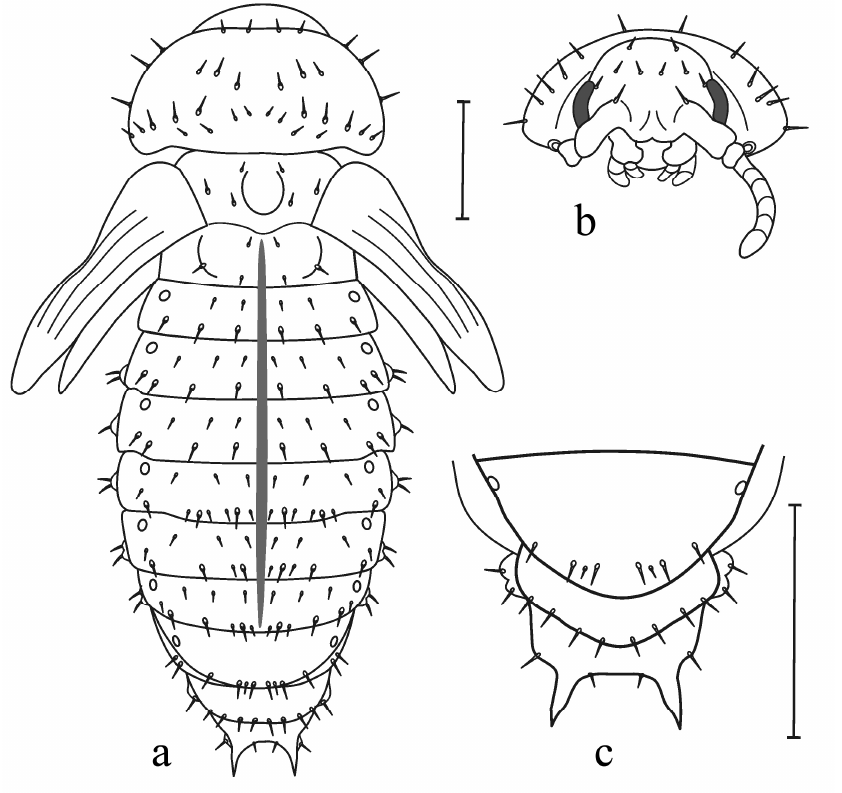
Figure 4. Pupa of Apterocuris sibirica: ( a )—dorsal view, ( b )—head, ( c )—abdominal segments 7–9 with urogomphi. Scale bar—1 mm.